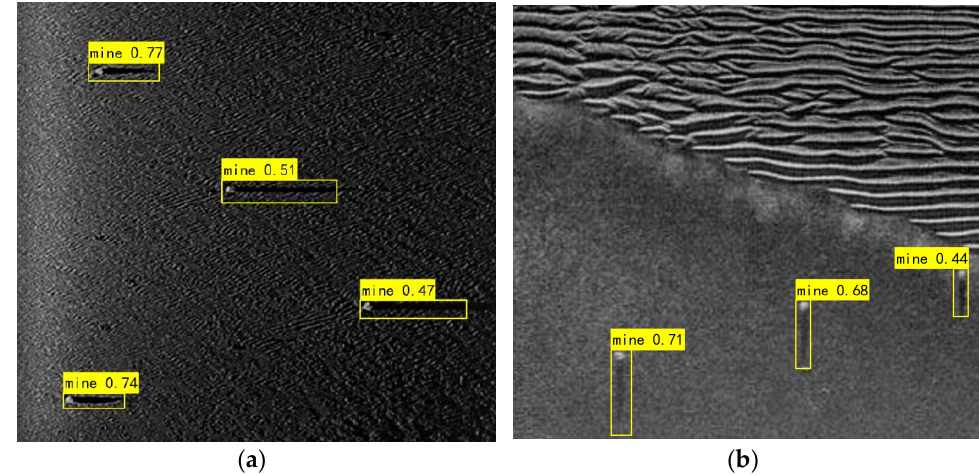
Figure 15. Experimental results of mine detection using SARTL combined with MSARM: ( a ) Mines on rippled seabed; ( b ) Mines near sand ridges.